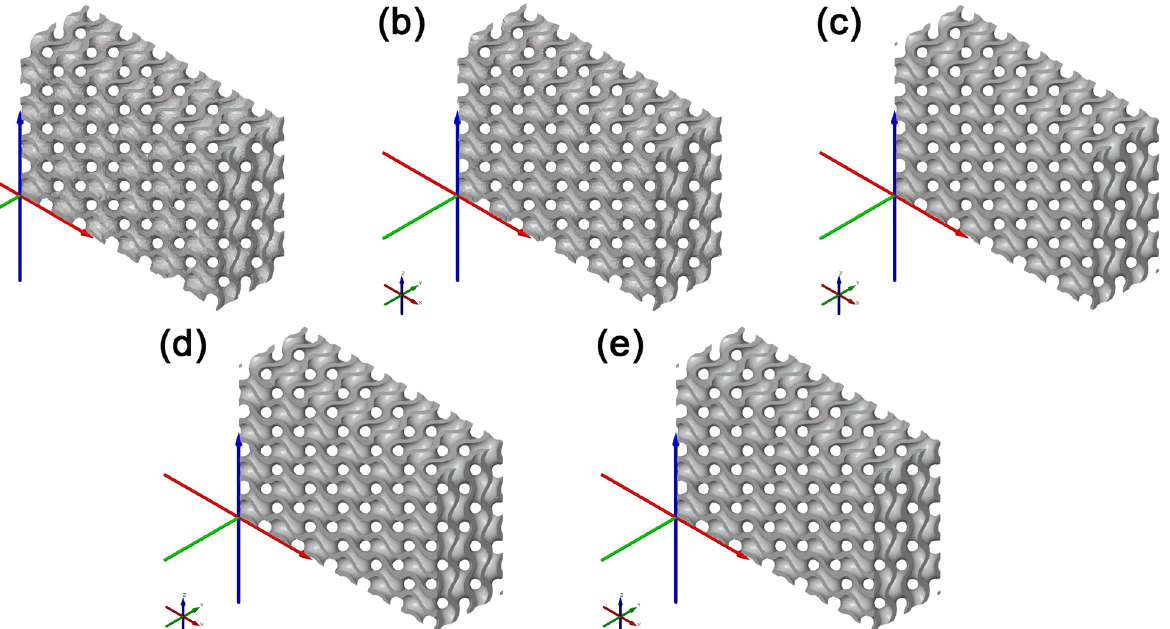
Figure 1. Designing the Gyroid structure in PTC Creo. ( a ) Graphic rendering during the creation of the Gyroid structure through the Lattice feature; ( b ) created Gyroid structure.